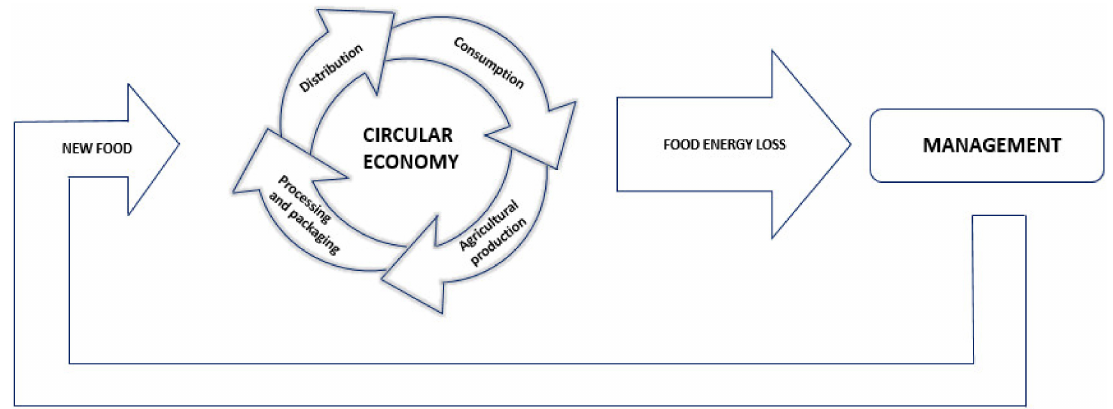
Figure 1. Conceptual diagram of the proposal of this work, recovering energy from food loss with a circular economy